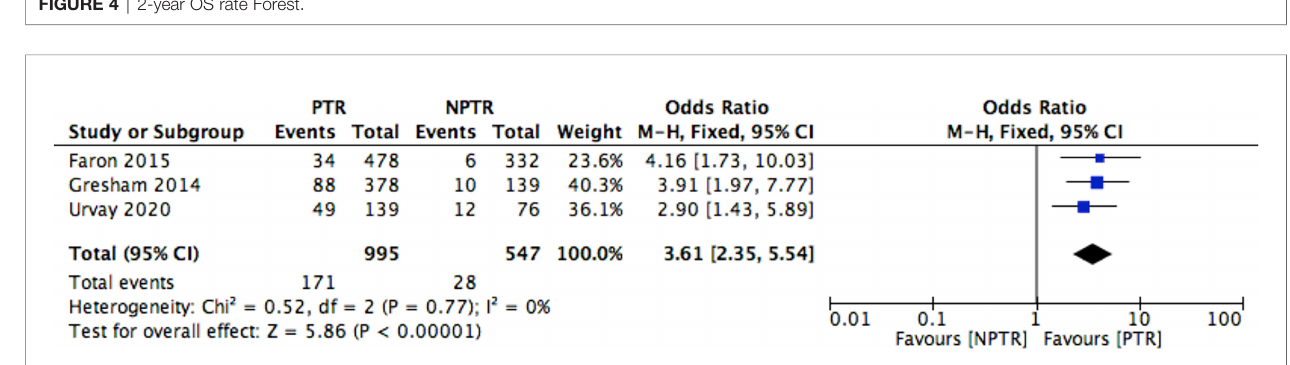
FIGURE 5 | 3-year OS rate Forest.